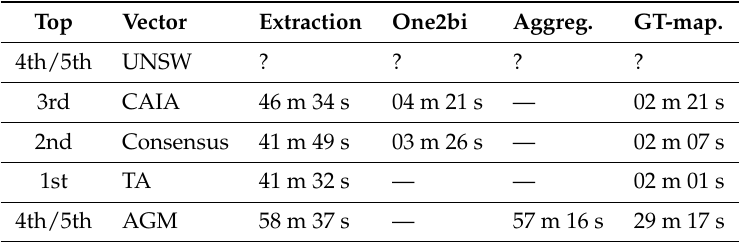
Table 4. Feature extraction and preprocessing time